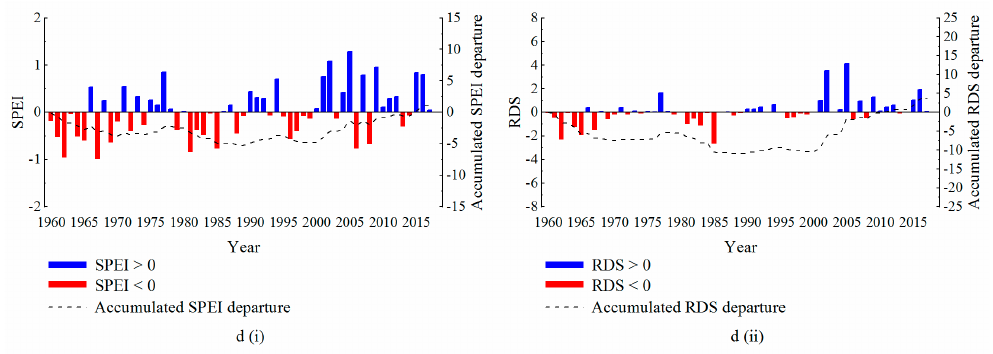
Figure 4. The changes in the SPEI ( i ) and RDS ( ii ) values, over the years in spring ( a ), summer ( b ), autumn ( c ), and winter ( d ).